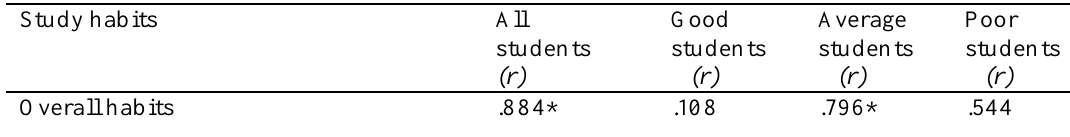
Table 9 Correlations between Overall Habits and Average Scores of Sub-Groups Study